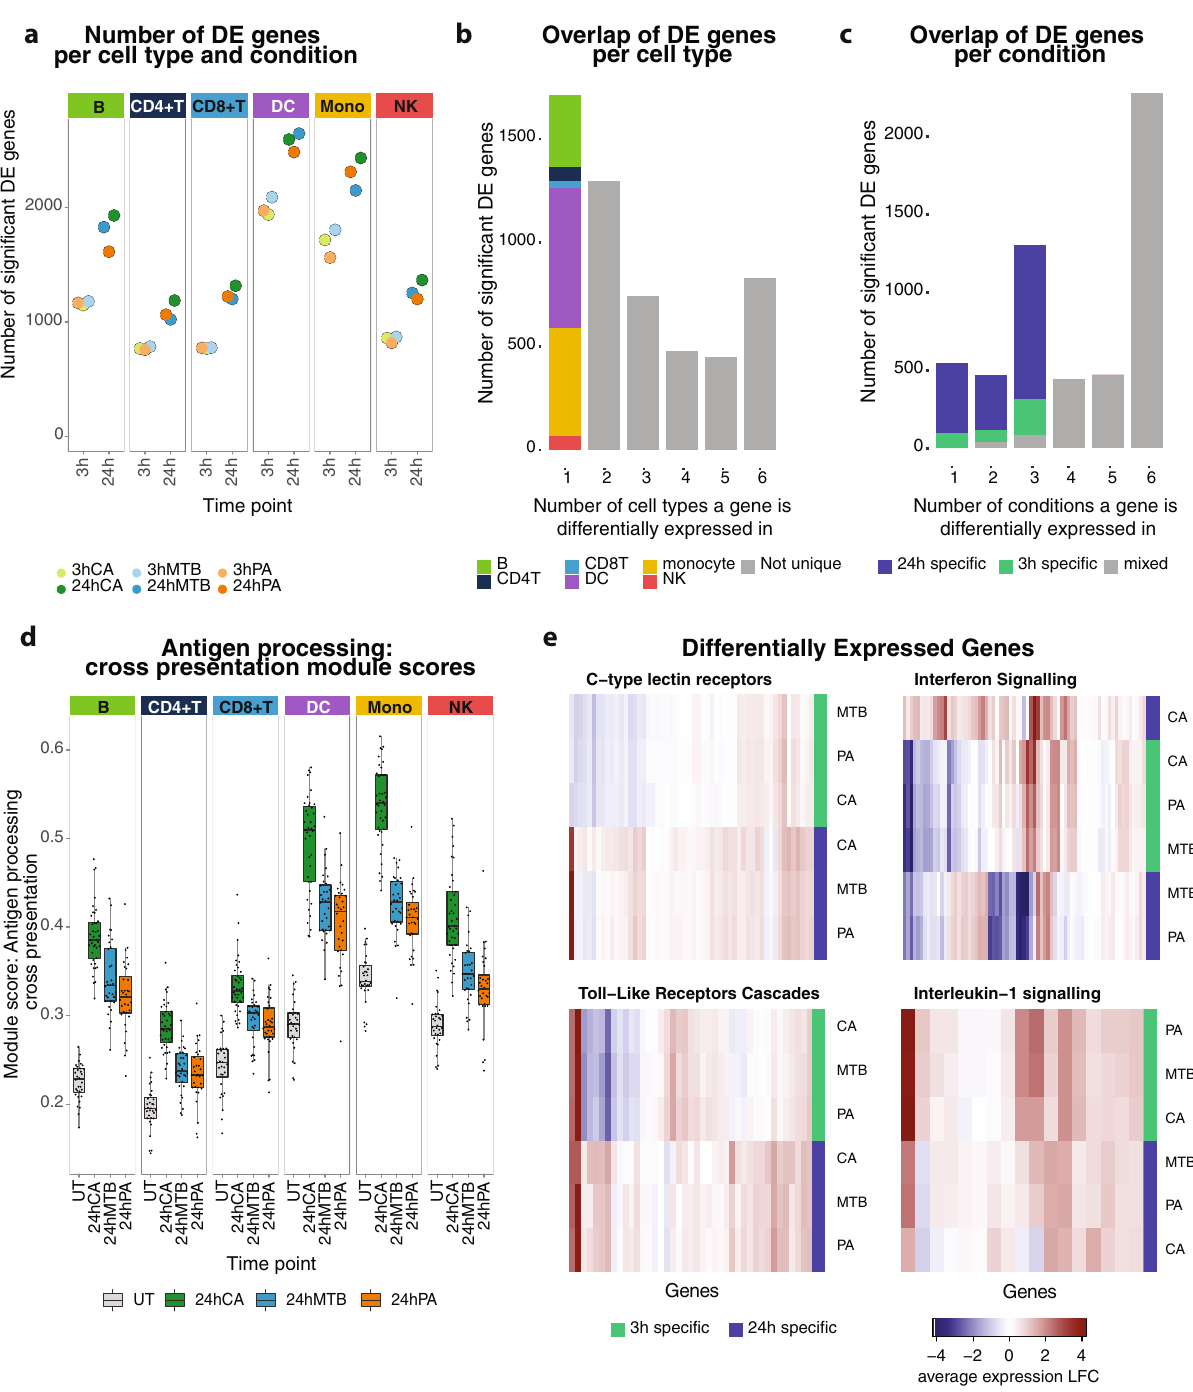
Fig. 2 Differentially expressed genes and pathways upon pathogen stimulation. a Number of DE genes per cell type upon 3 h (light colors) or 24 h (dark colors) stimulation with C. aAlbicans (CA, green), M. tTuberculosis (MTB, blue), or P. aAeruginosa (PA, orange). b Bar plot showing the overlap of DE genes across cell types. The fi rst bar, depicting the cell-type-speci fi c DE genes, is colored based on the cell type in which the DE gene is found. c Bar plot showing the overlap of DE genes across pathogen ‒ timepoint combinations (3 h vs 24 h stimulation with CA, PA or MTB). Bars are colored based on the length of stimulation. d Boxplots (showing median, 25th and 75th percentile, and 1.5× the interquartile range) representing the module score of the antigen- processing cross-presentation pathway across all individuals per cell type and per 24 h pathogen-stimulated condition. Each dot shows the average module score per individual (V3 chemistry is shown, the Source Data fi le includes the individual data points). e Heatmaps showing the immune-related DE genes in monocytes (V3 chemistry is shown), split by their involvement in either one of the four selected immune pathways associated with pathogen recognition and its downstream signaling. C-type lectin and toll-like receptors show more general activation upon pathogen stimulation, whereas interleukin-1 and interferon signaling show a more speci fi c expression pattern with timepoint (3 h stimulation) or stimulation (CA), respectively. DE summary statistics can be found in Supplementary Data 5. The number of individuals and cells included in each analysis can be found in the Source Data fi